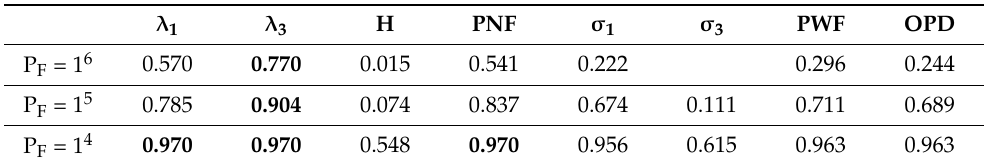
Table 3. Probabilities of detection for quad-polarimetric sea ice. Bold numbers indicate highest P D values.